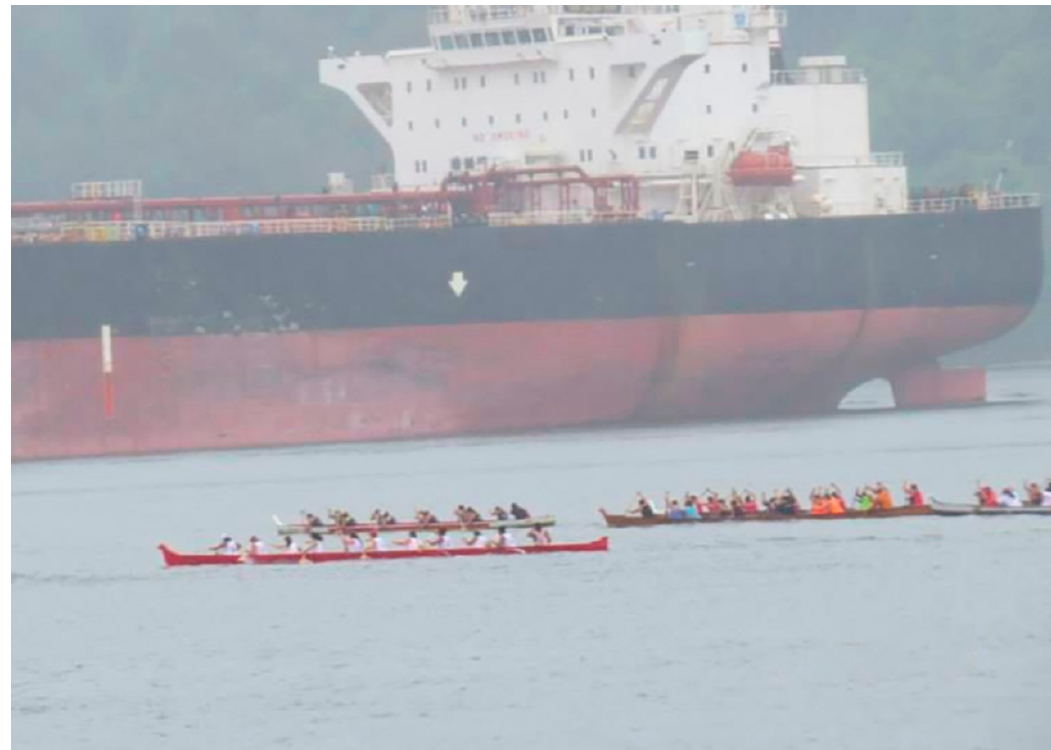
Figure 2. Showing a canoe beside a tanker (Photo Credit: Jen Thomas).